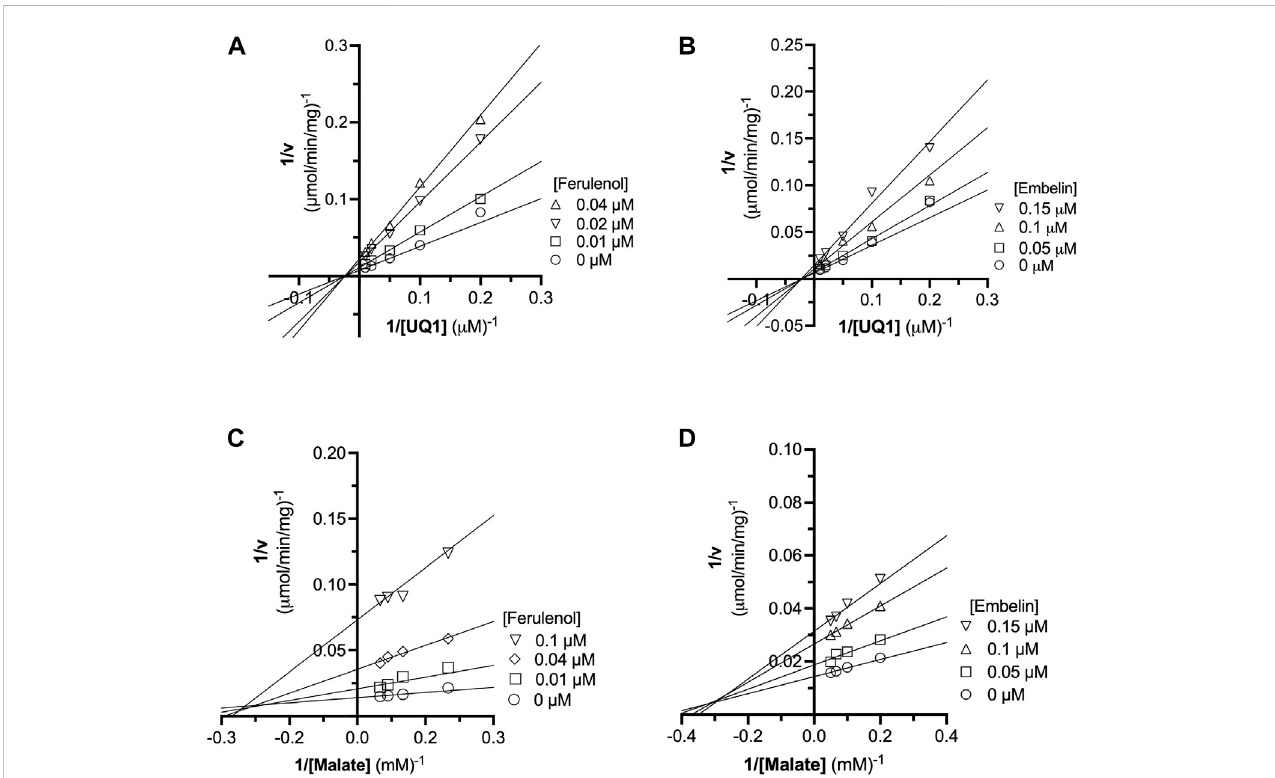
FIGURE 4 Analysis of ferulenol and embelin inhibition mechanism using double reciprocal plot. The inhibition mechanism of ferulenol was determined by varying the concentrations of UQ1 (A) or malate (C) while maintaining the concentrations of ferulenol. Similarly, the inhibition mechanism of embelin was performed by changing the concentration of UQ1 (B) or malate (D) at fi xed concentrations of embelin. In all scenarios, the double reciprocal plot yielded straight lines intersecting in the second quadrant or at X-axis. Further analyses by fi tting the data to the general mixed-type equation (Table 3) and using graphical methods (Supplementary Figures 12, 13), further supports that embelin and ferulenol were noncompetitive inhibitors versus quinone and mixed-type versus malate.